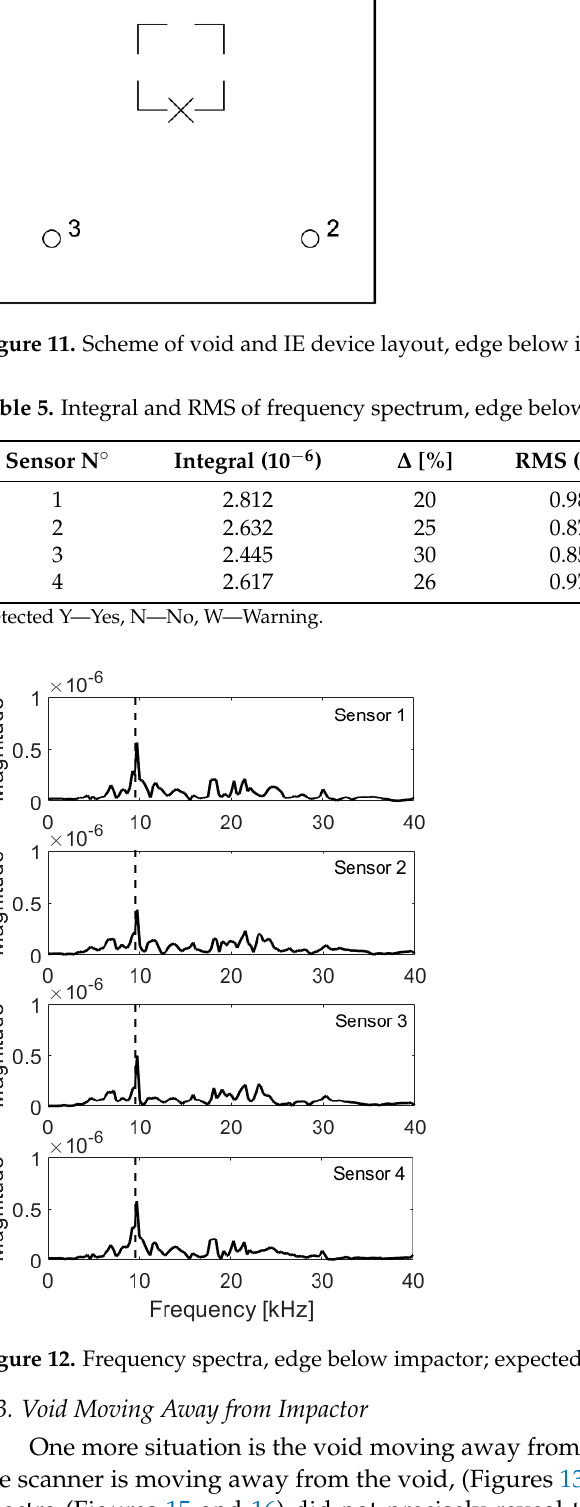
Table 5. Integral and RMS of frequency spectrum, edge below impactor. Sensor N°